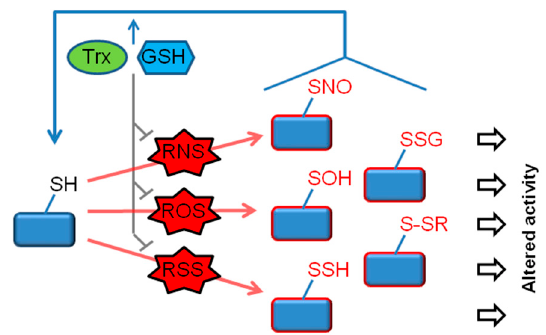
Figure 1. Functional modifications of the thiol proteome. In response to generation of reactive oxygen/nitrogen/sulfur species (ROS/RNS/RSS), protein cysteine thiols (R–SH) undergo a range of